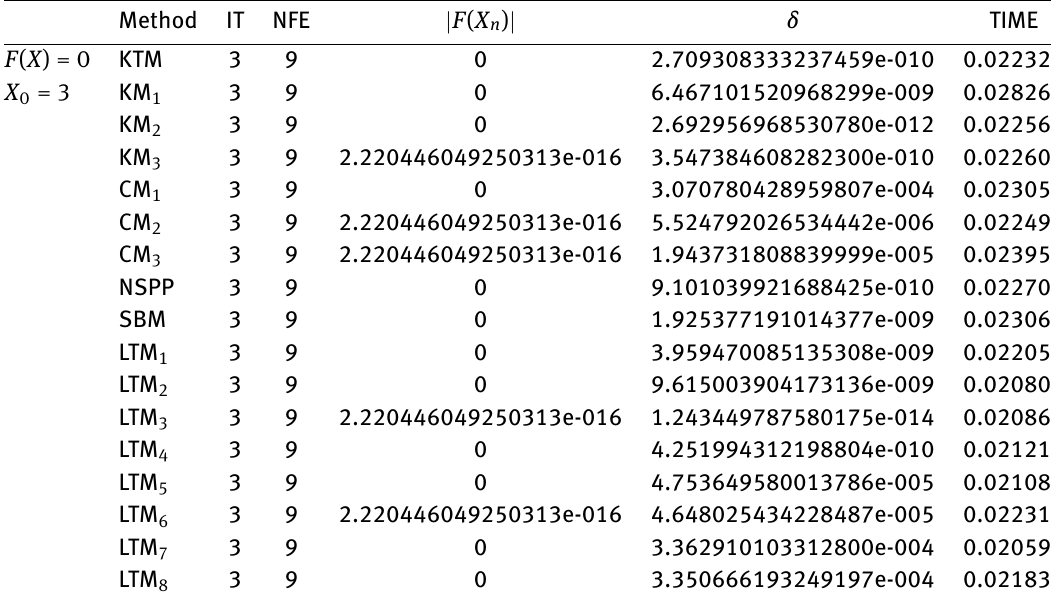
Table 4: Comparison of fourth-order methods for the physical